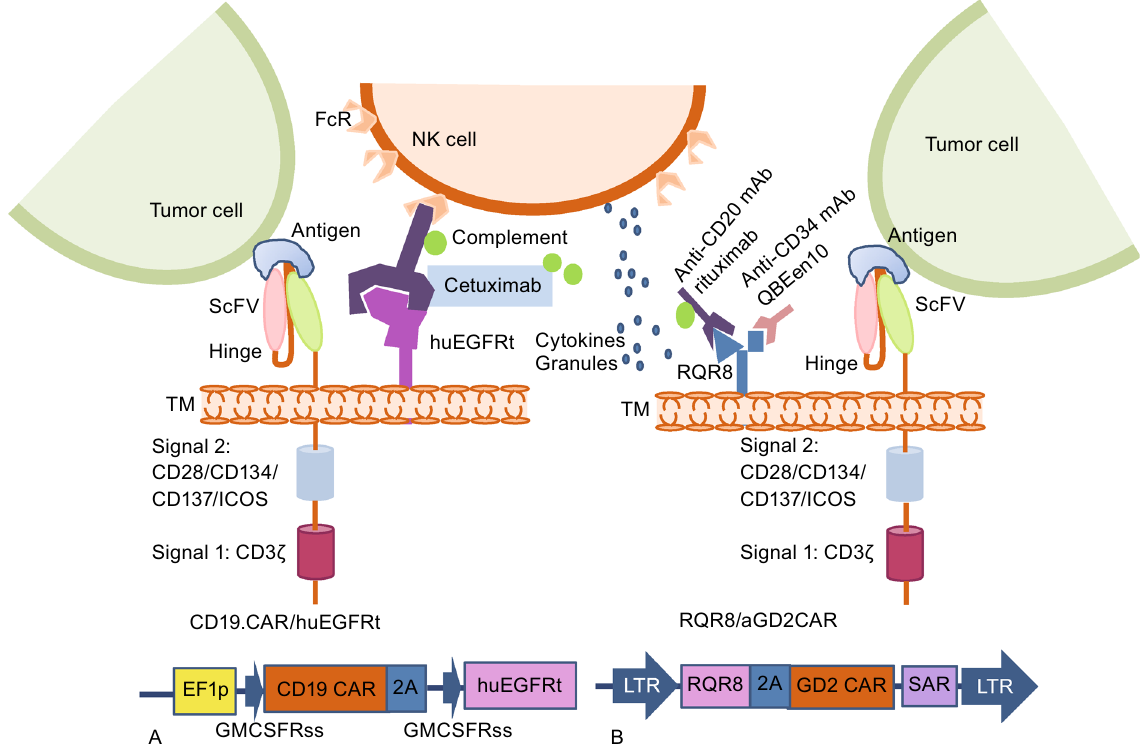
Figure 4. CAR T cell with “ OFF switch ”— co-expression with a truncated protein or a small epitope peptide. In the presence of the mAb of the anti-epitope/truncated protein, the mAb binds the truncated protein or epitope peptide and mediates antibody- dependent cell-mediated cytotoxicity (ADCC) or complement-dependent cytotoxicity (CDC) to trigger cell lysis. The design strategy of an AND logic gate that requires “ antigen + mAb ” . NK cell, natural killer cells; FcR, Fc receptor; cetuximab, a chimeric monoclonal antibody against epidermal growth factor receptor; huEGFRt, a truncated human EGFR polypeptide; ScFv, single chain variable fragment; ICOS, inducible Tcell costimulator; TM, transmembrane; EF1p, elongation factor 1 promoter sequences; GMCSFRss, the GM-CSF receptor- α chain signal sequences; RQR8, a 136-amino-acid marker with epitopes for CD34 and CD20 as a suicide molecule. SAR, scaffold attachment